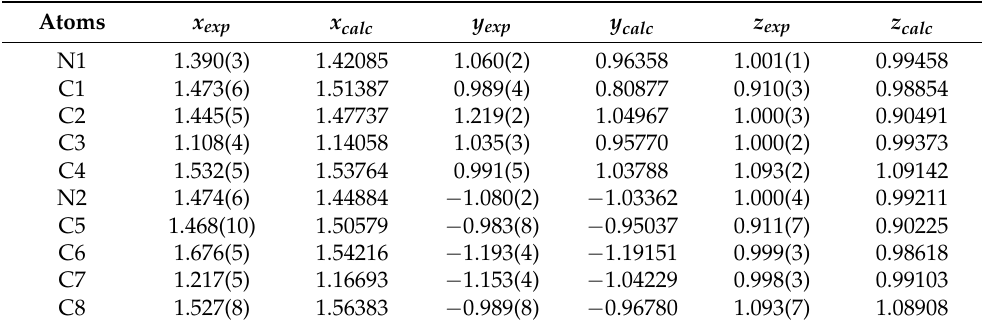
Table 7. Comparison of optimized atomic positions for TMA cations in the L model to the experi- mental structure [38].